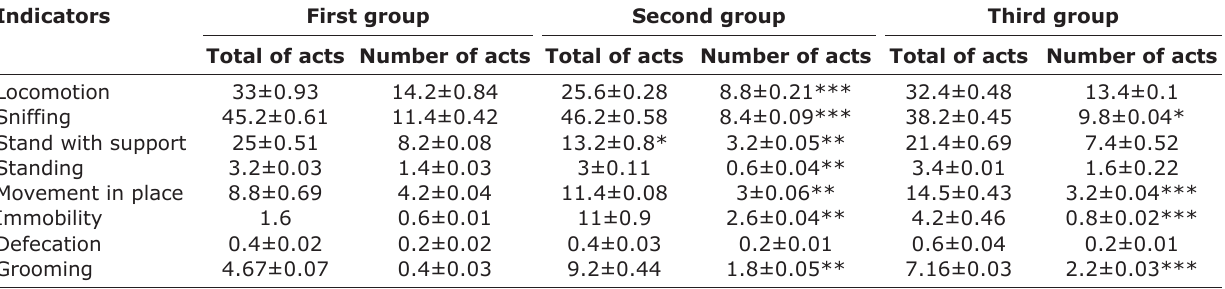
Table-1: Changes in the behavioral reactions of rats when exposed to electromagnetic radiation of the phones Samsung Galaxy J1 Mini and Xiaomi Redmi S2 phones. Indicators First group Second group Third group Total of acts Number of acts Total of acts Number of acts Total of acts Number of acts